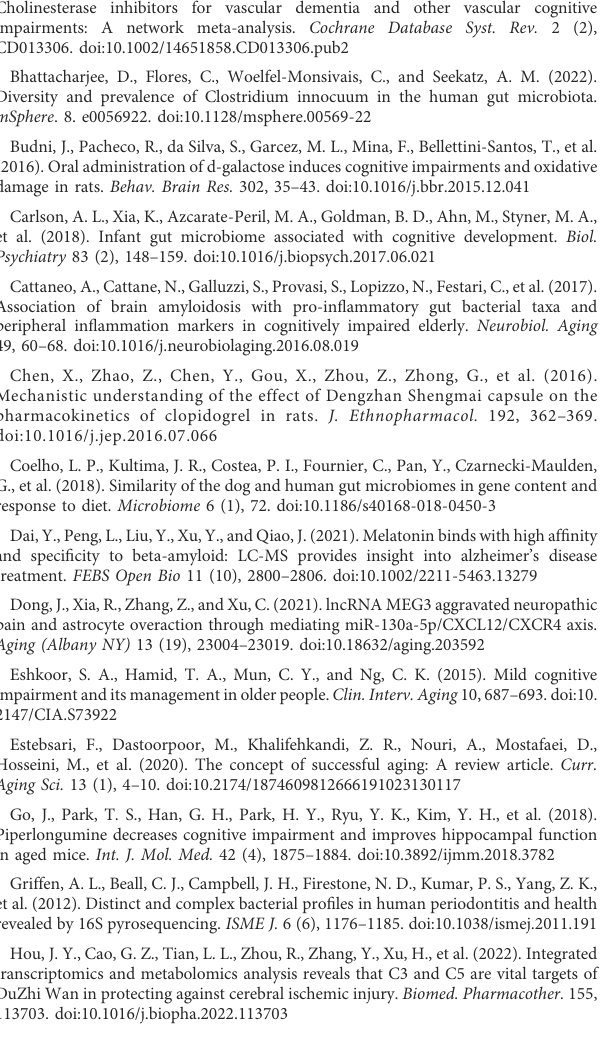
SUPPLEMENTARY FIGURE S1 UPLC/MSanalysisofDZMS. (A) ChromatogramofDZSMinpositiveESImode; (B) Chromatogram of DZSM in negative ESI